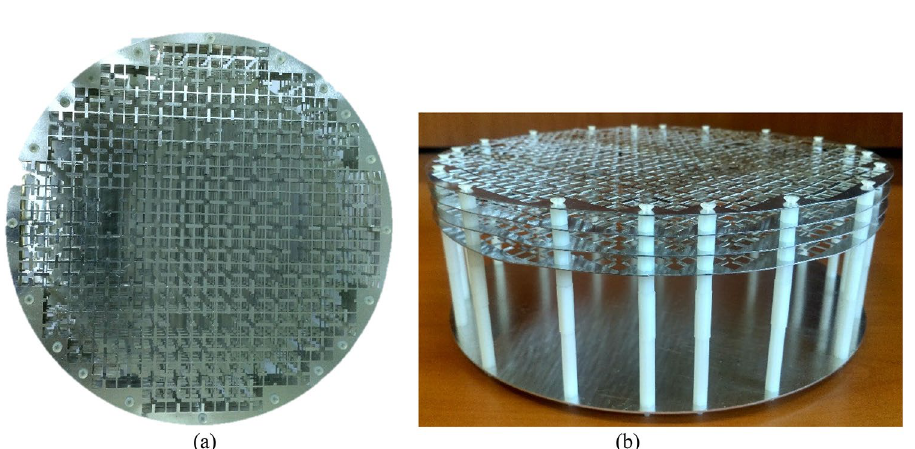
Figure 13. The top ( a ) and side view ( b ) of the fabricated